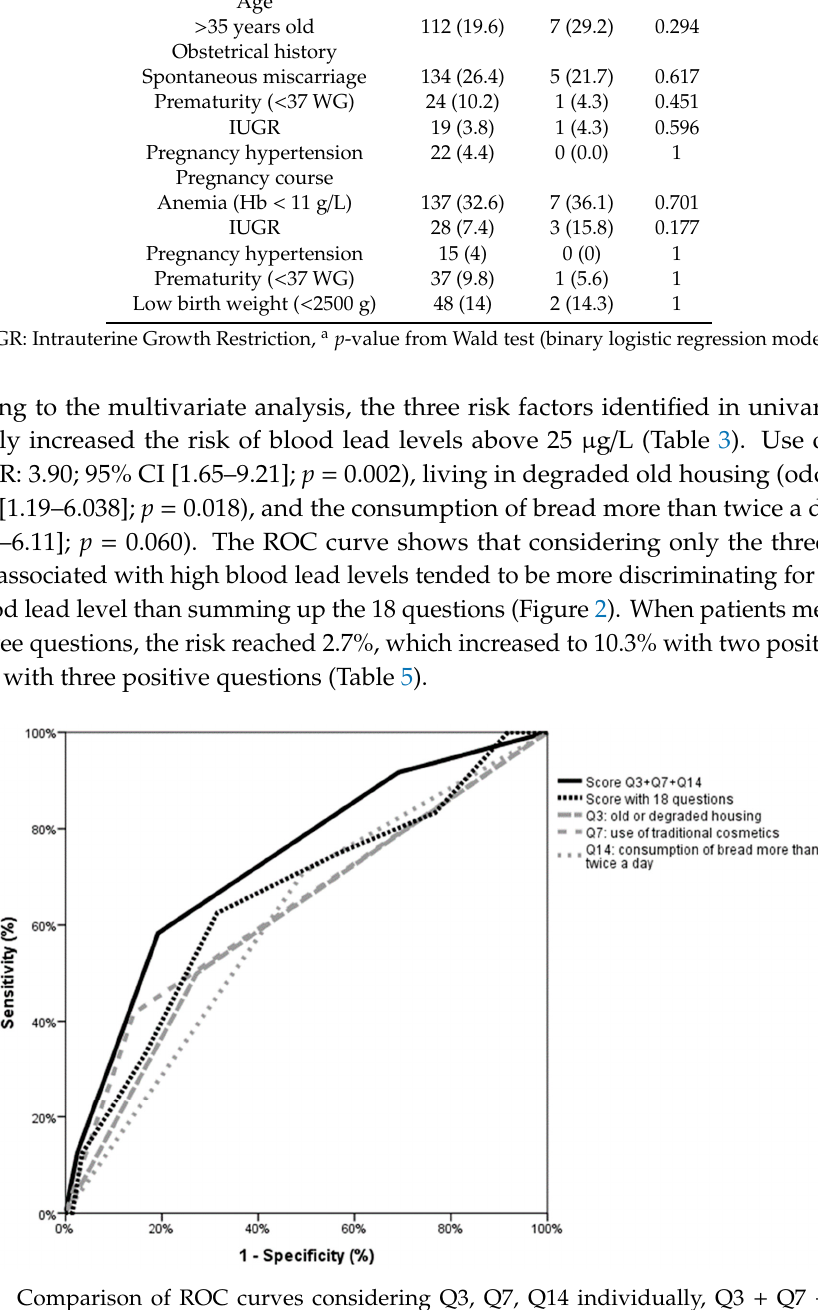
Table 5. Calculation of an overall score from exposure factors significantly associated with high blood lead levels ( n = 596).